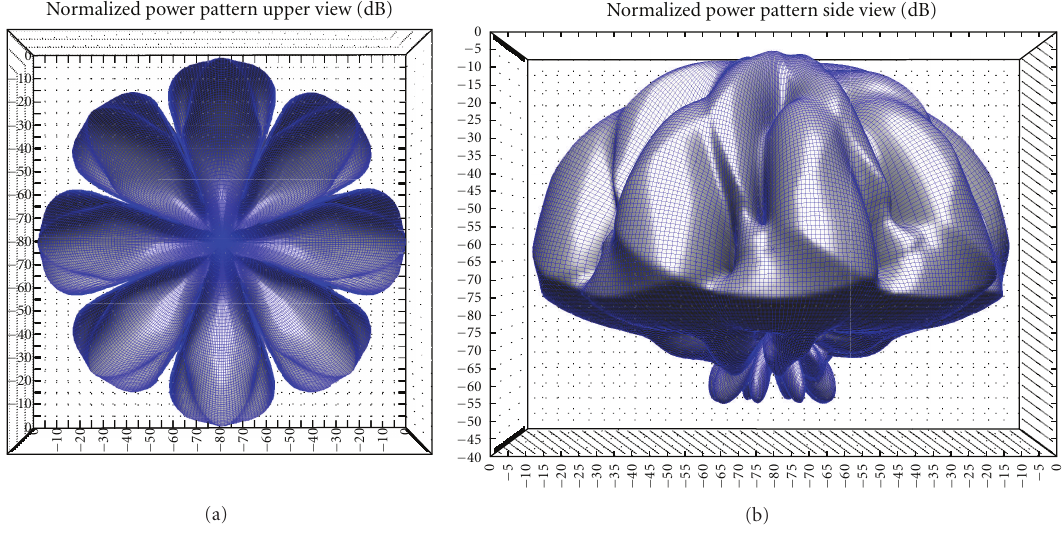
Figure 8: (a) Upper view and (b) side view of the 3D polar radiation